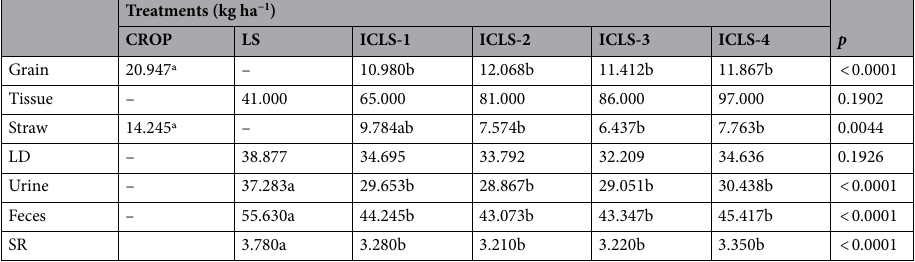
Table 2. Data the maize grain, animal tissue (Tissue), litter deposited (LD); animal manure and stocking rate (SR) in the agricultural systems during two years of experiment. Means followed by distinct letters are statistically different, according to the Tukey’s test at a 5% probability level. CROP production of maize grain, LS production of beef cattle in pasture, ICLS-1 maize and Marandu grass sowed simultaneously without herbicide, ICLS-2 maize and Marandu grass sowed simultaneously with herbicide, ICLS-3 delayed sowing of maize and Marandu grass, ICLS-4 maize and Marandu grass sowed simultaneously in maize lines and interlines with